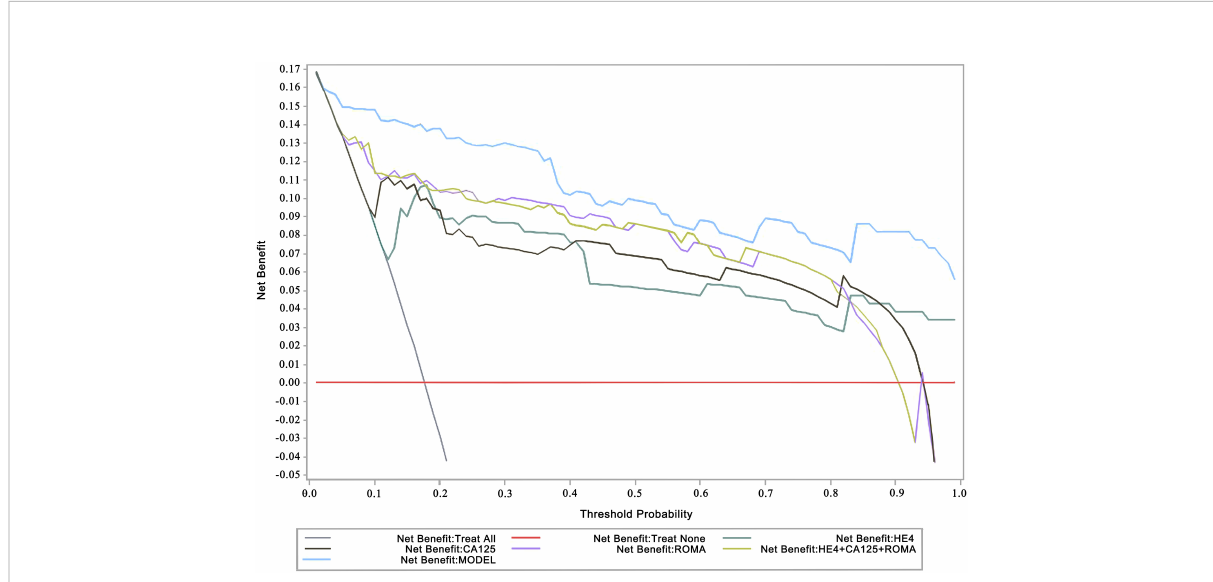
FIGURE 2 Decision curve analysis (DCA) for detection of malignant ovarian tumors. The x-axis represents the threshold probability. The y-axis measures the net bene fi t. The threshold probability is where the expected bene fi t of treatment balances the expected bene fi t of avoiding treatment. ROMA, the Risk of Ovarian Malignancy Algorithm; CA125, human carbohydrate antigen 125/mucin-16; HE4, human epididymis protein 4 The ROMA scores were calculated following: premenopausal women, PI= − 12.0+2.38×LN [HE4]+0.0626×LN [CA125]; postmenopausal women, PI= − 8.09+1.04×LN [HE4]+0.732×LN [CA125]; and ROMA (%) =